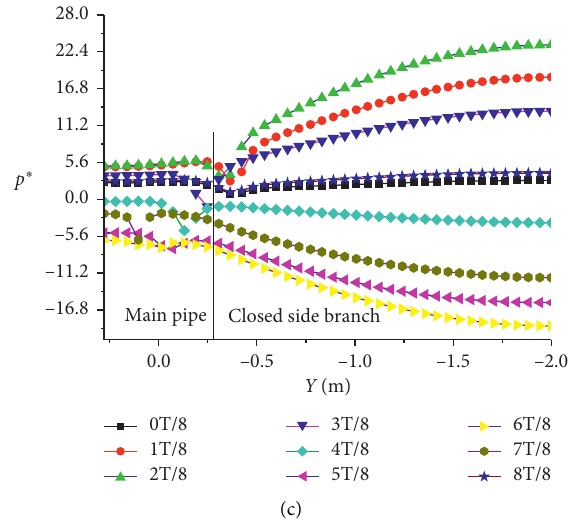
Figure 15: Standing wave along closed side branch: (a) t 1 � 0.1 s–0.12s, (b) t 2 � 0.6123s–0.6323 s, and (c) t 3 � 1.7s–1.72s.